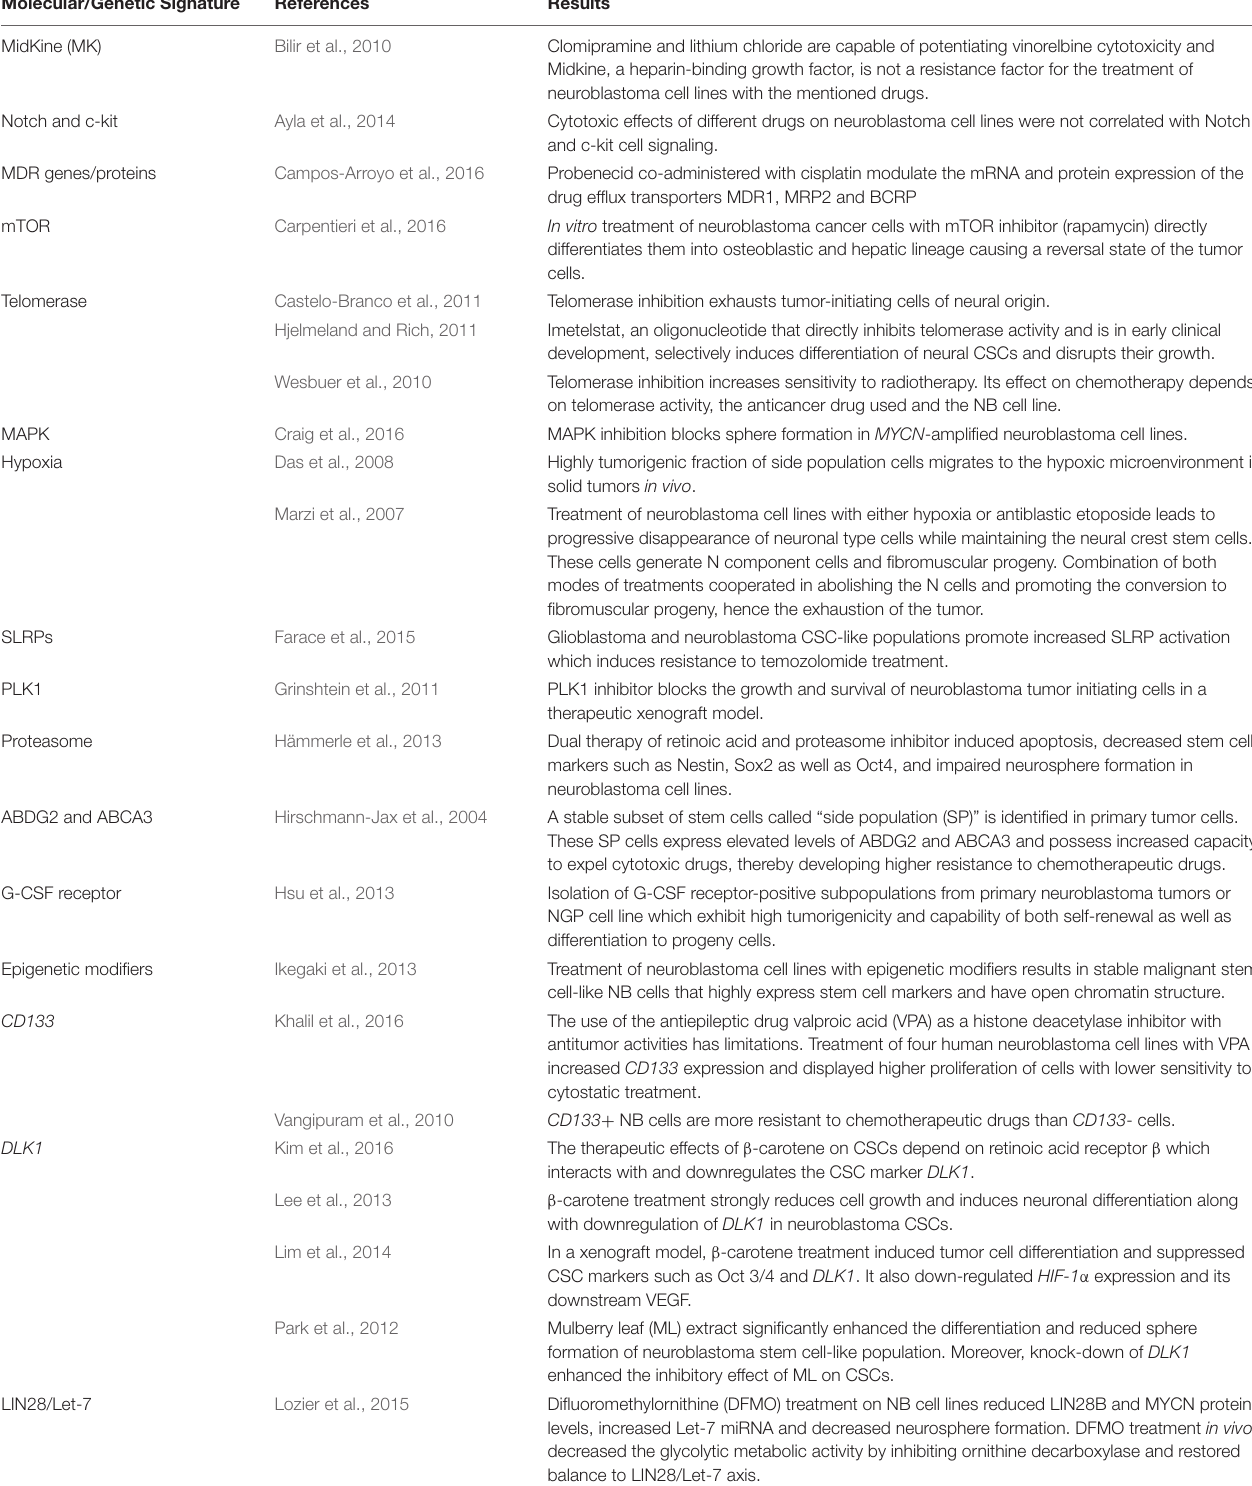
TABLE 2 | Summary table of the major CSC-targeted therapeutic approaches and